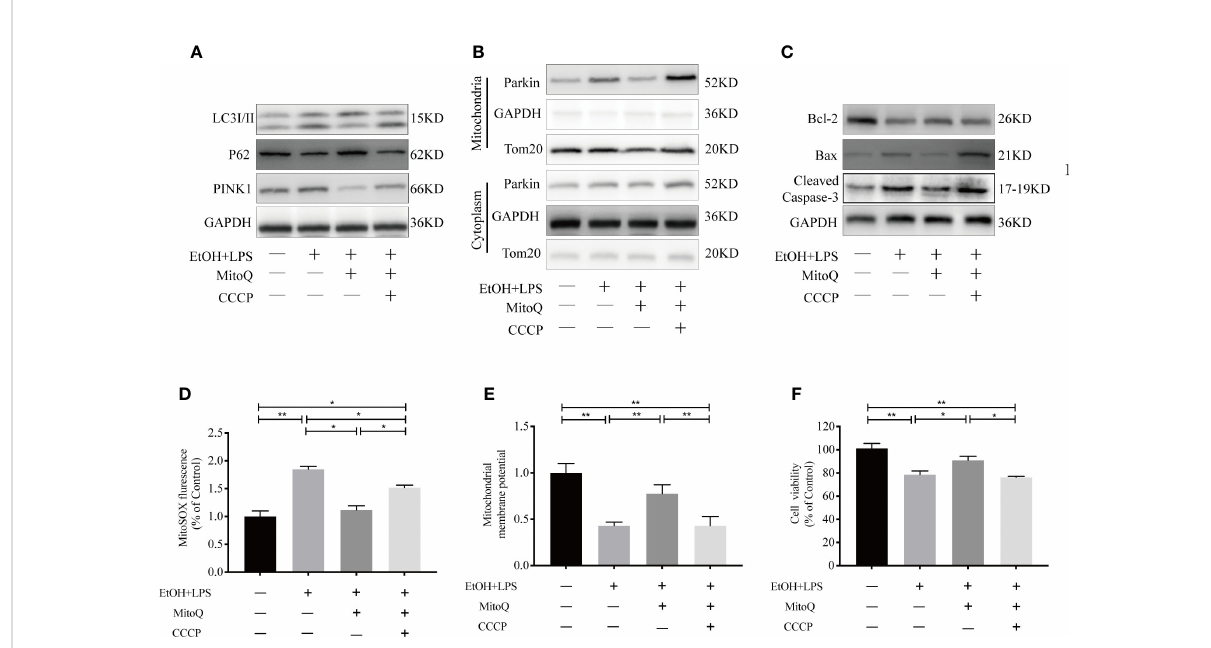
FIGURE 9 Mitophagy increased ethanol-LPS-induced injury in Raw264.7 cells. Cell were treated with EtOH (25 mM) for 48 h and LPS (1 mg/mL) for 6 h, before the addition of ethanol in cell culture mediums pre-treated with 10 m M CCCP for 30 mins. (A) Western blotting analyzed mitophagy- related proteins LC3, P62, and PINK1. (B) Expression of Parkin protein in mitochondria and cytoplasm in Raw264.7 cells were detected by western blotting. (C) Expression of protein Bax, Bcl-2, and Caspase-3 were detected by western blotting. (D) Mitochondrial ROS was analyzed by fl uorescence microplate. (E) The mitochondrial membrane potential ( DY m) was subjected to Rho123 fl uorescence analysis. (F) Cell viability in Raw264.7 cells were measured by a CCK8 kit. Data were presented as mean ± SEM (n=5 in each group), *P < 0.05, **P <